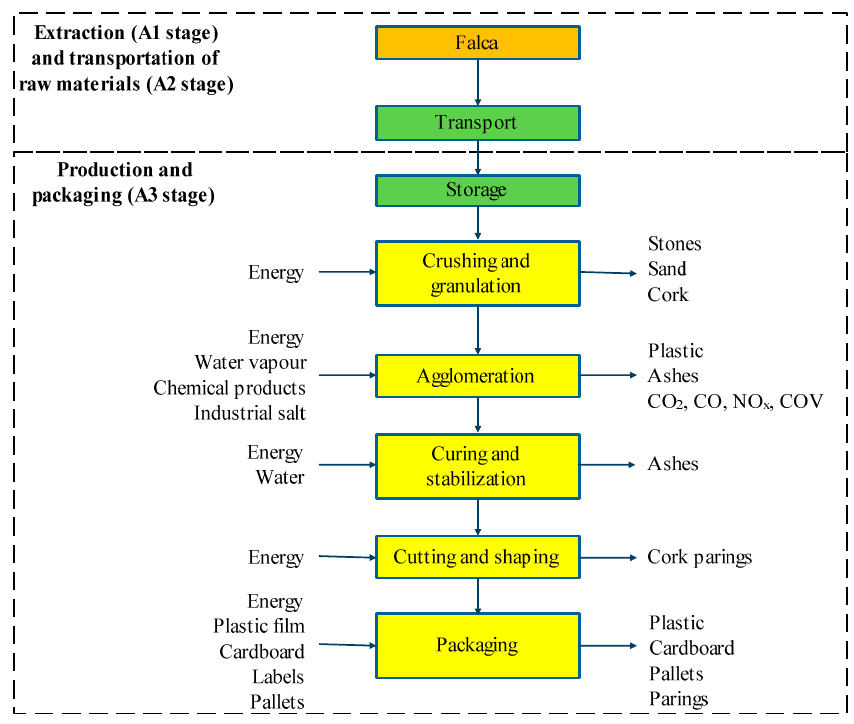
Figure 3. Main stages of ICB production and corresponding inputs and outputs. Table 2. Detailed life cycle stages of building materials classification based on European